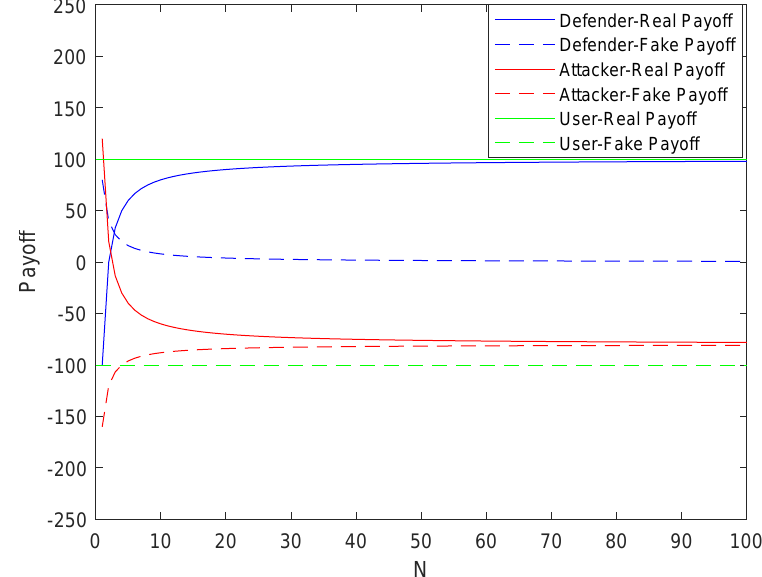
Figure 9. Payoff curves of the three-party.